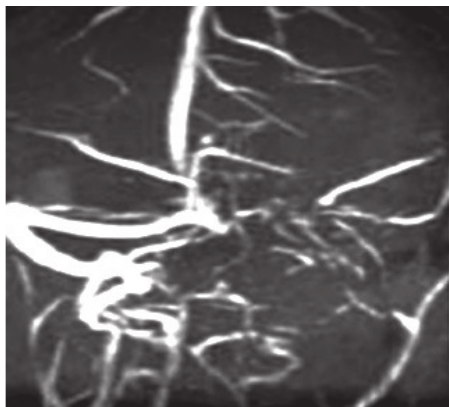
Figure 2: MR Venogram Showing obliteration of left Transverse and Sigmoid sinus